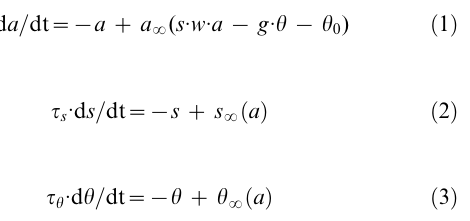
(Table 1). The two parameters w and h 0 set the global network excitability [8]. Connectivity ( w ) represents the amount of positive feedback due to excitatory connections, i.e., it determines the fraction of network output (activity) fed back as input to the network. The average cellular threshold ( h 0 ) measures the cellular excitability, i.e., it biases the cells’ responses to synaptic inputs. In Eq (1) we see that synaptic depression, which decreases s , acts as a divisive factor, decreasing the amount of positive feedback, while cellular adaptation, which increases h , is a subtractive factor.